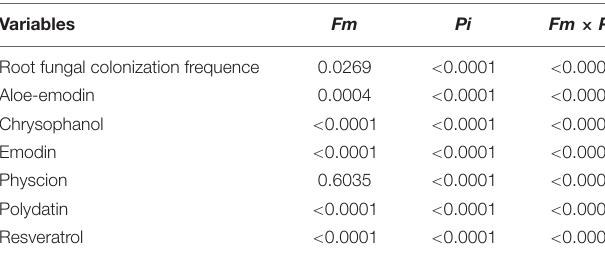
TABLE 1 | Significance of selective variables between Fm inoculation and Pi inoculation.